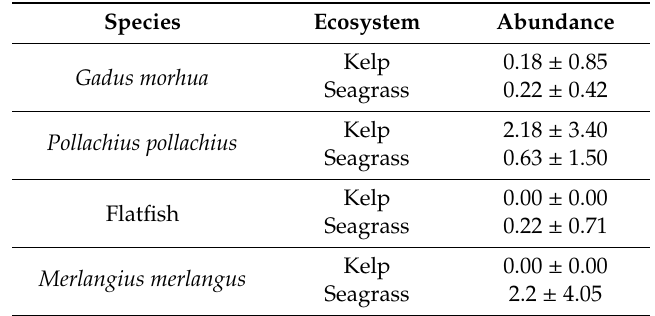
Table 4. The mean abundance ( ± SD) of commercially important species (cod ( Gadus morhua ), pollock ( Pollachius pollachius ), flatfish (Including Limanda limanda , Platichthys flesus , and Pleuronectes platessa ), and whiting ( Merlangius merlangus )) in seagrass and kelp ecosystems from BRUV samples across the UK from April to September